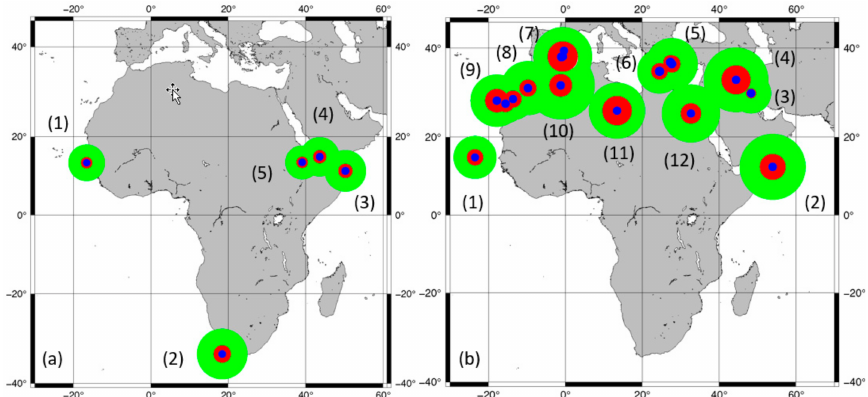
Figure 11. Phoenix heterogeneity in taxa from Africa, West Asia and the Mediterranean. The red and green circles are proportional to the heterogeneity of the group, before and after normalization, and the blue circles are proportional to the mean intraindividual variability of the accessions in each group. ( a ) AFR: 1, P. spinosa ; 2, P. reclinata var. reclinata ; 3, P. caespitosa ; 4, P. arabica ; 5, P. abyssinica